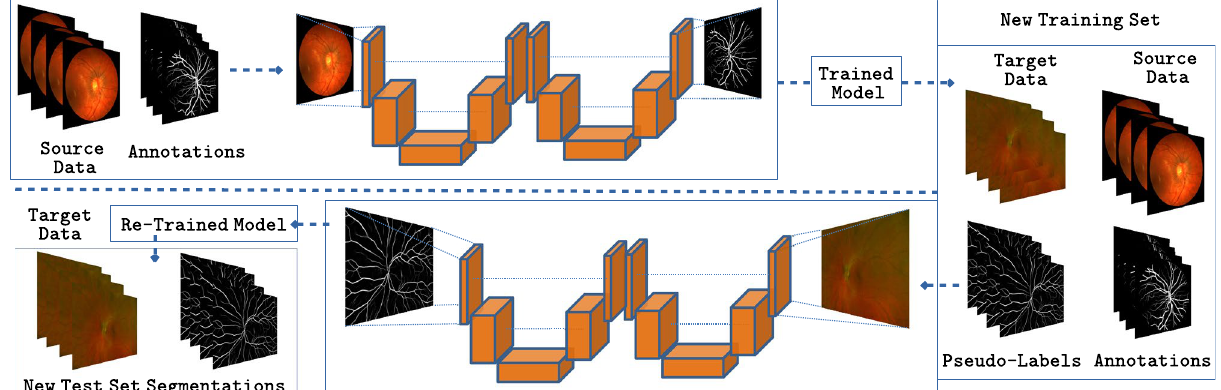
Figure 3. Domain Adaptation strategy employed in this work: a model trained on source data is used to generate Pseudo-Labels on a target dataset. The original source data and the target data with Pseudo-Labels are used to fine-tune the model and produce better